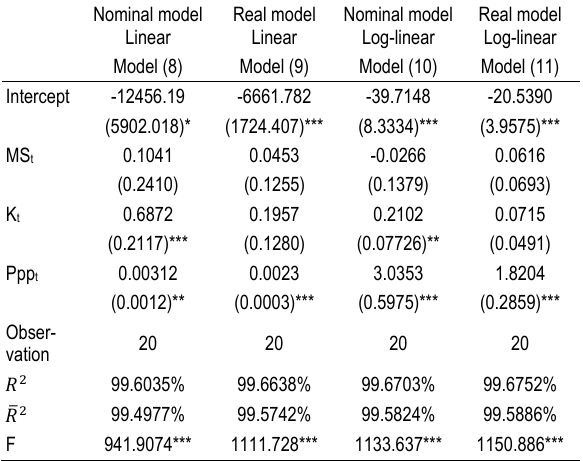
Table 3. The effect of money supply on output level. GDP is the dependent variable